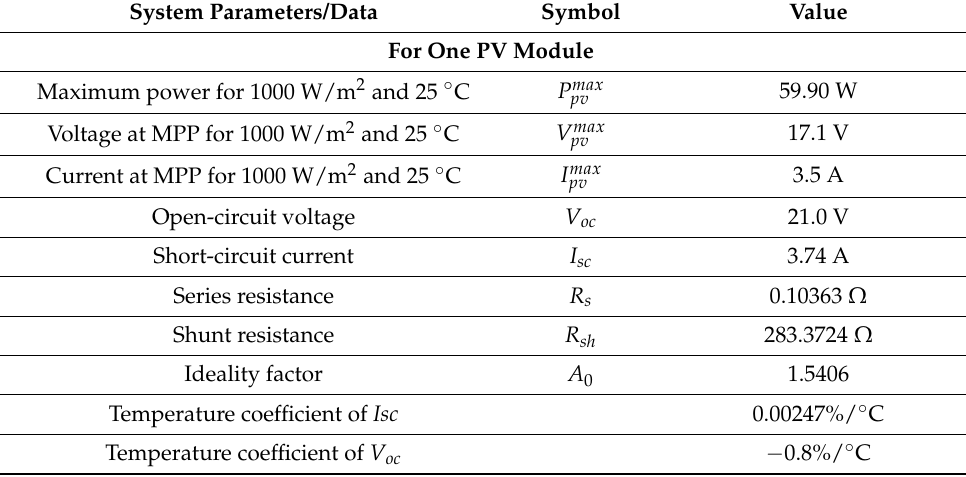
Table 1. Studied solarex MSX60 PV module parameters [43].